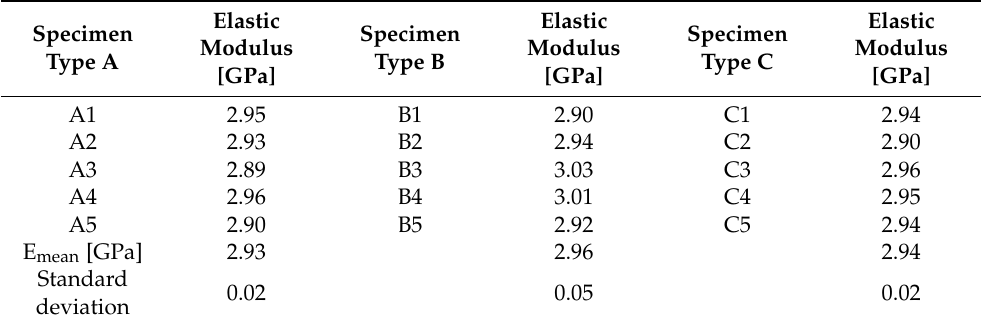
Table 2. The values of the elasticity modulus obtained for particular specimens from the tensile static tests.